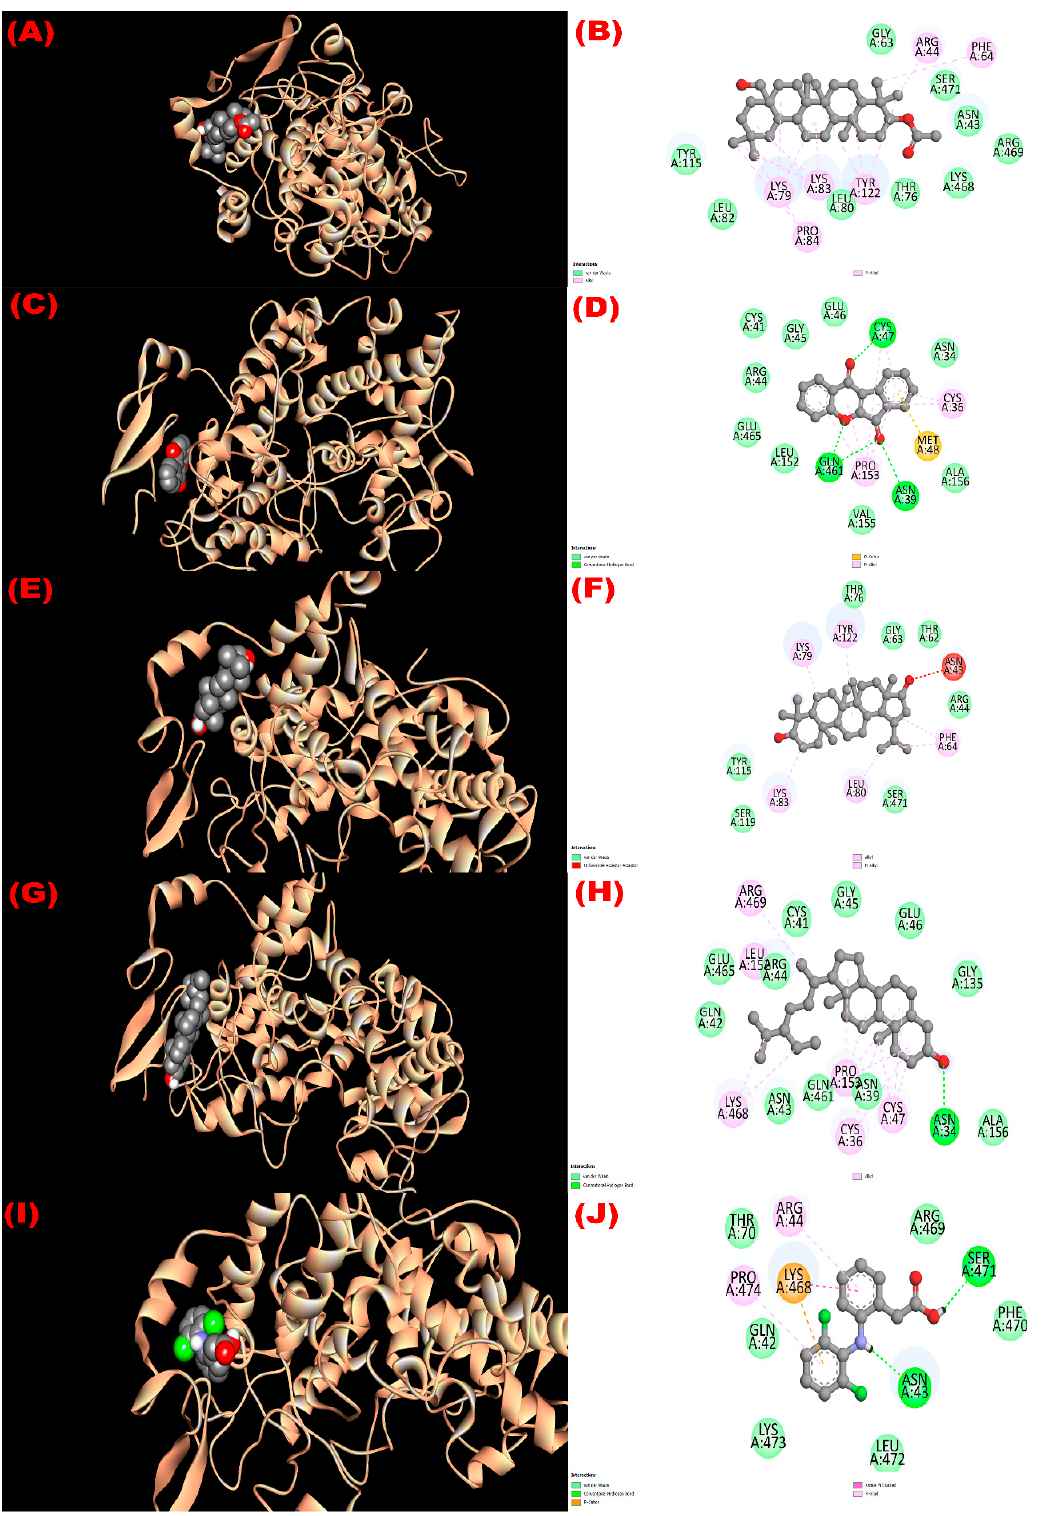
Figure 7. The 3D and 2D view of molecular interactions of the isolated compounds with the cyclooxygenase 2 (COX-2) (PDB ID: 1CX2) revealing the peripheral analgesic activity. (( A , B ), ( C , D ), ( E , F ), ( G , H ), ( I , J ) sketched the pictorial view of molecular interactions of compounds ( 1–4 ) 3 β -acetyloxy-olean-12-en-28-ol, wrightiadione, 22 β -hydroxylupeol, β -sitosterol, and the standard diclofenac, respectively).